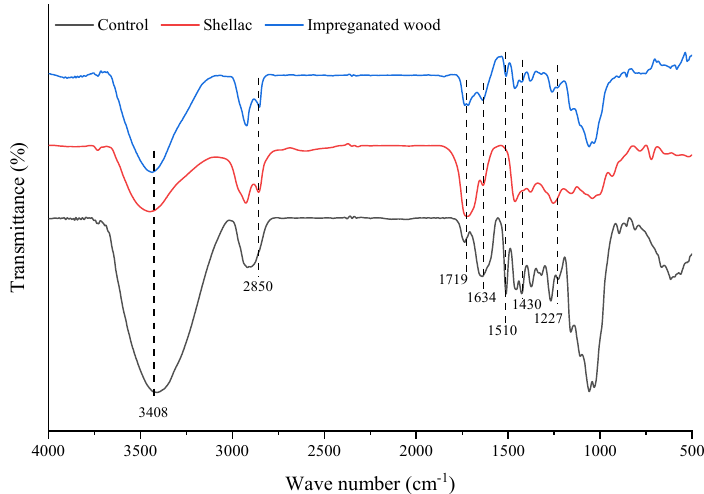
Figure 8. FTIR spectroscopy of the wood samples impregnated with shellac solution.